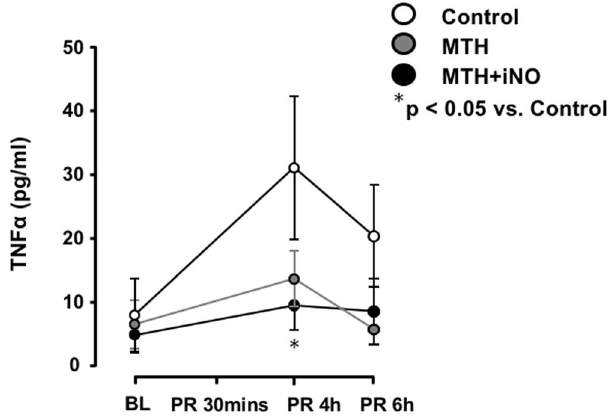
Figure 1. Alterations in TNF α levels before CA and after return of spontaneous circulation (ROSC). The significantly attenuated inflammatory response in the MTH + iNO group in comparison to Controls four hours post ROSC was reversed at hour six. * p < 0.05 vs control; mean ± SEM.